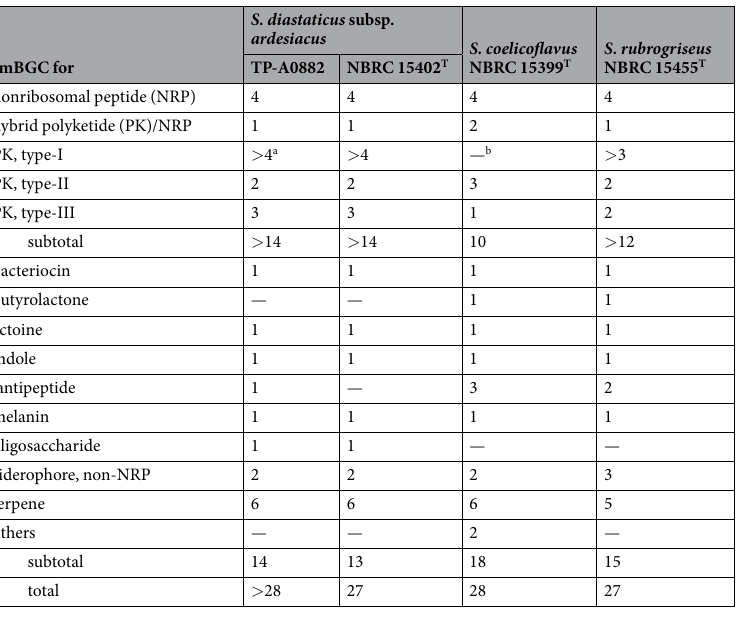
Table 3. Numbers of secondary metabolite-biosynthetic gene clusters (smBGCs) encoded in each genome. a As